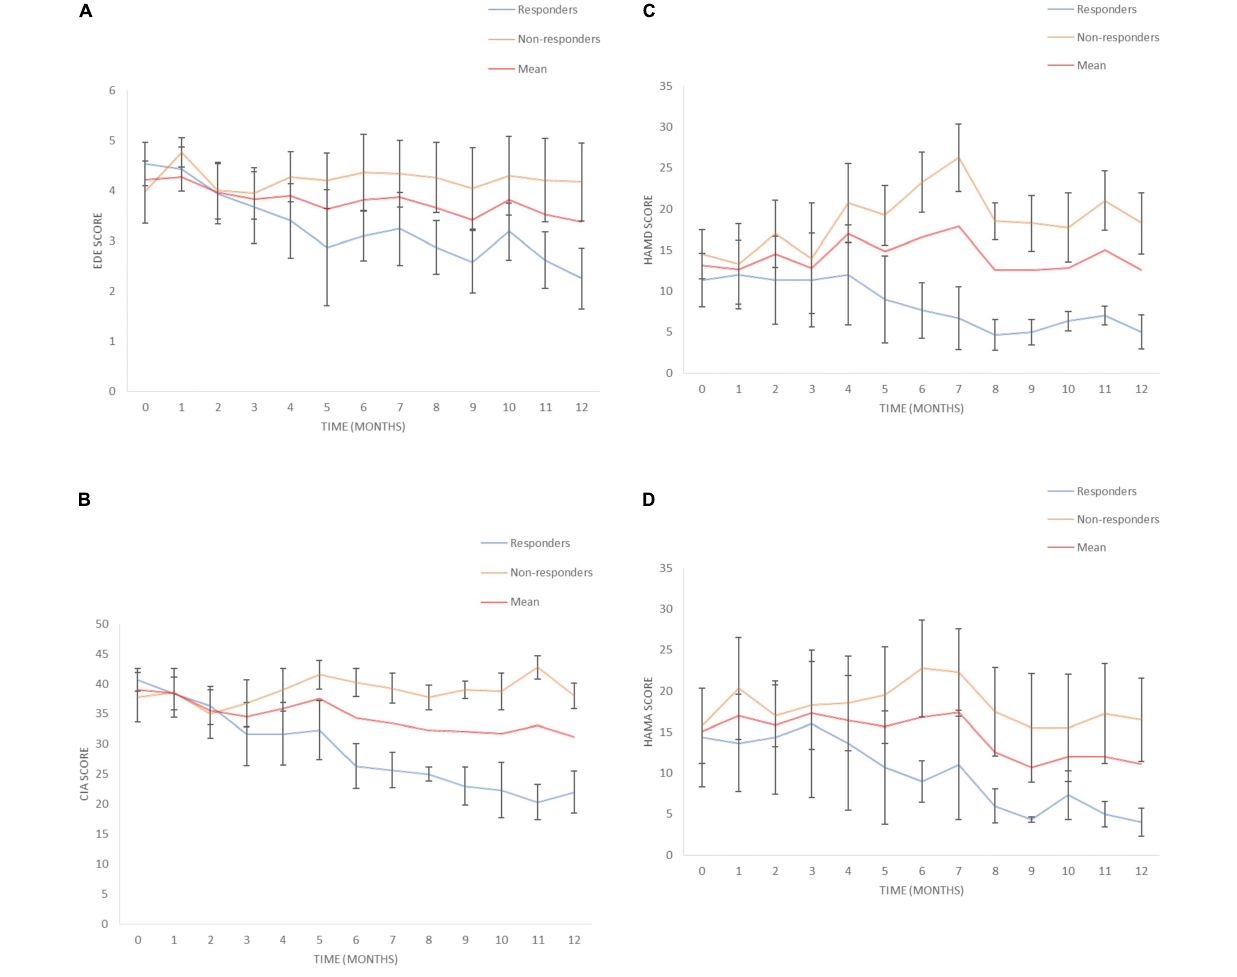
FIGURE 4 | Eating disorders pathology over time. (A) Eating Disorder Examination (EDE) scores for responders and non-responders. (B) Clinical Impairment Assessment (CIA) scores for responders and non-responders. (C) Hamilton Depression Scale (HAMD) scores for responders and non-responders, (D) Hamilton Anxiety Scale (HAMA) scores for responders and non-responders. Mean and SEM